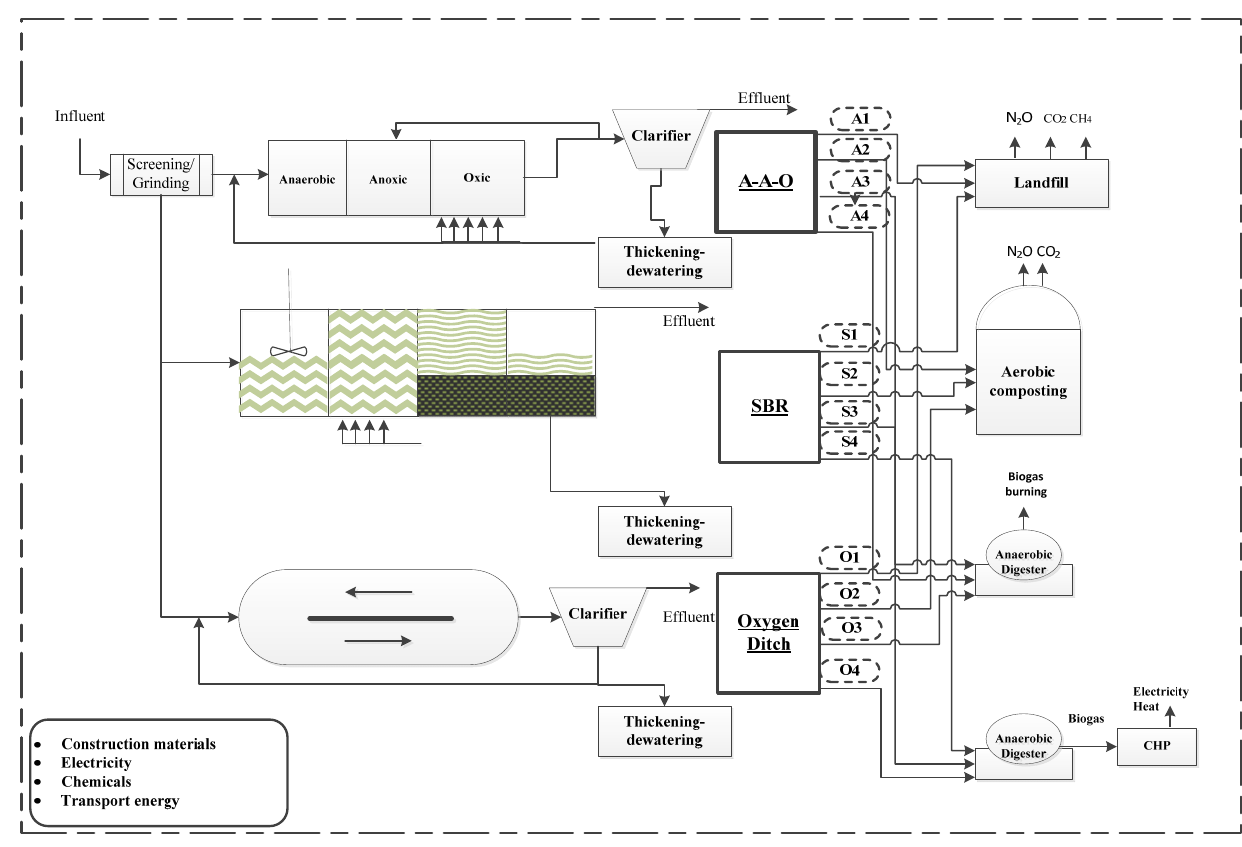
Figure 1. System boundary of this study and studied scenarios for wastewater and sludge